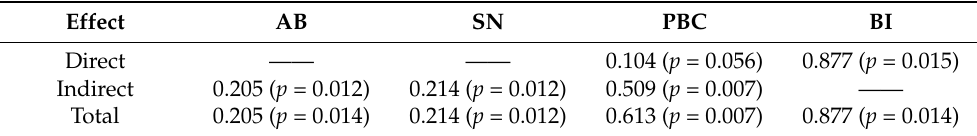
Table 7. Standardized direct effect, indirect effect, and total effect of each latent variable to